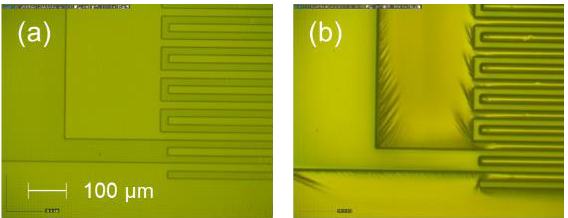
Figure 9. Typical undesirable patterns remaining on the surface of the patterned PEDOT:PSS ob- served using an optical microscope.